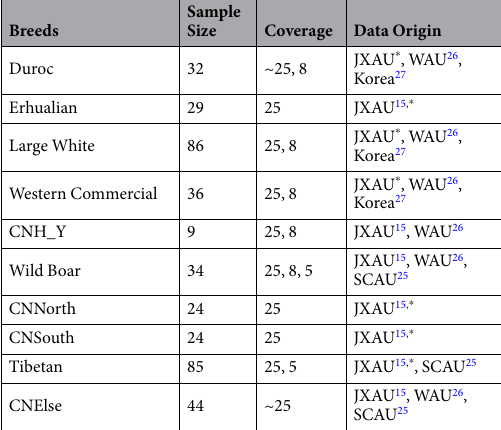
Table 1. The components of the reference panel. Breed and origin abbreviations: CNH_Y: China Huai River and Yangtze River area pig; CNNorth: China North pigs; CNSouth: China South pigs; CNElse: China local pigs from other places. JXAU: Jiangxi Agricultural University; WAU: Wageningen University; SCAU: Sichuan Agricultural University; Korea: Korea University. * These part of data were sequenced by our laboratory and accessible under readers’